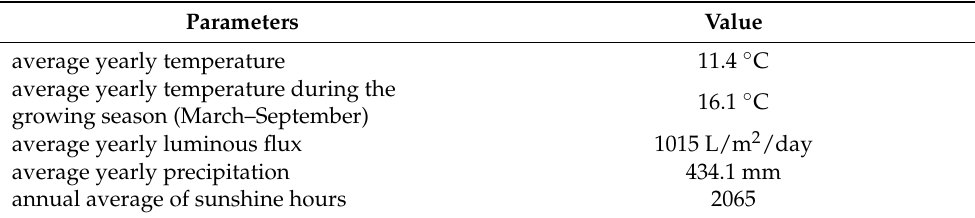
Table 2. Meteorological data during the data collection